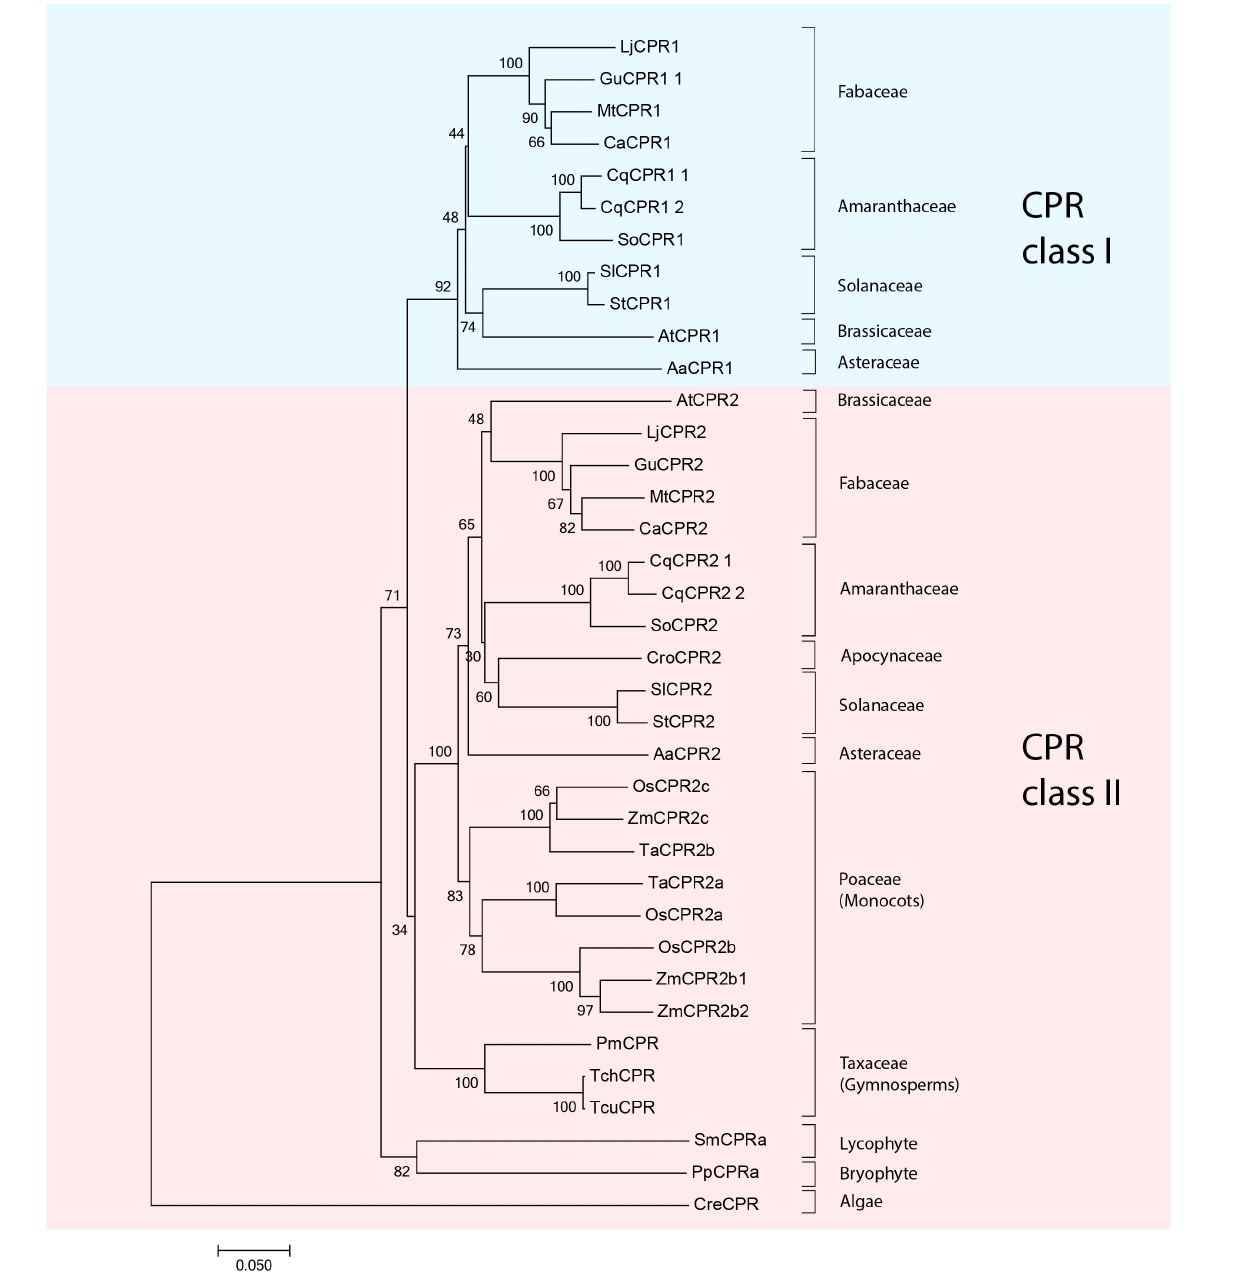
(Fukushima et al., 2011; Tamura et al., 2017; Suzuki et al., 2019; Figure 1 ). Both MtCYP72A63 and GuCYP72A154 oxidize the C-30 position of β -amyrin to produce 30-OH β -amyrin, but only MtCYP72A63 catalyzes the further oxidation to produce